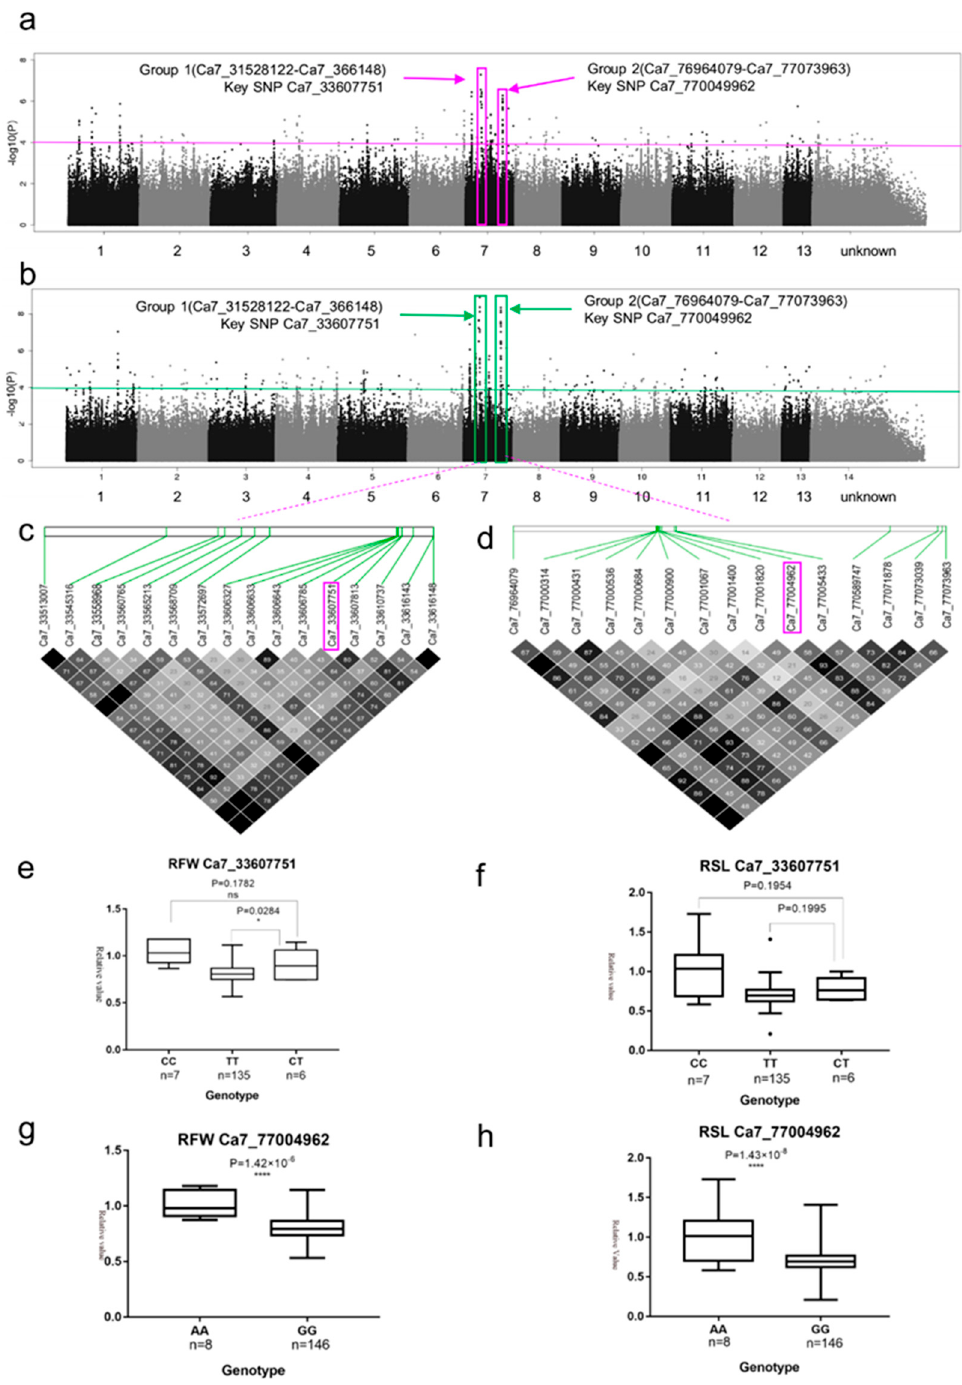
Figure 3. GWAS results for RFW and RSL, and analysis of the peaks on chromosome 7 (Group 1 and Group 2). ( a ) Manhattan plot for RFW. The horizontal line represents the significant threshold (-log 10 P = 4). The pink color surrounds represent SNP rich regions (Group1 and Group2). ( b ) Manhattan plot for RSL. The horizontal line represents the significant threshold (-log 10 P = 4). The pink color surrounds represent SNP rich regions (Group1 and Group2). ( c ) LD surrounding the peak of Group 1. ( d ) LD surrounding the peak of Group 2. ( e ) Phenotypic differences for RFW based on the key SNP (Ca7_33607751) of Group 1. ( f ) Phenotypic differences for RSL based on the key SNP (Ca7_33607751) of Group 1. ( g ) Phenotypic differences for RFW based on the key SNP (Ca7_77004962) of Group 2. ( h ) Phenotypic differences for RSL based on the key SNP (Ca7_77004962) of Group 2.